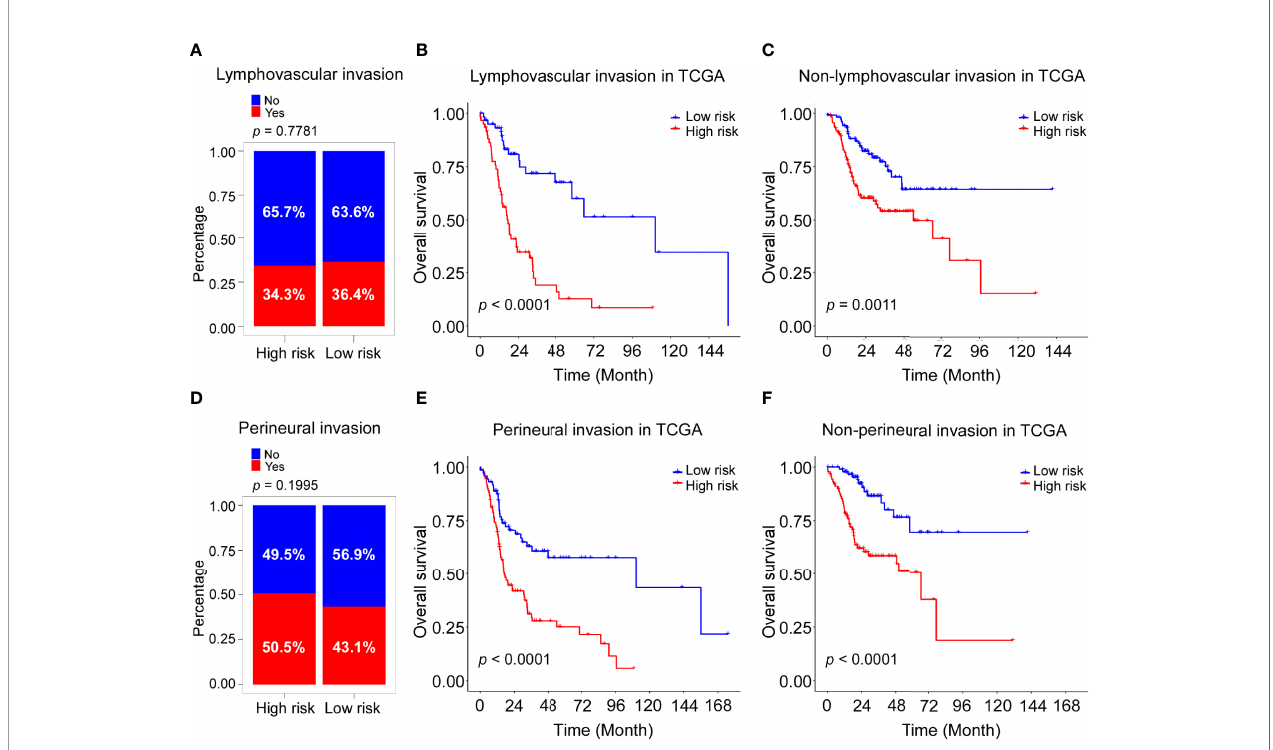
FIGURE 5 | Association of risk score with lymphovascular invasion and perineural invasion in TCGA cohort. (A) Rate of patients with lymphovascular invasion (Yes with No) in high and low risk groups in the TCGA-HNSC cohort. (B) Kaplan – Meier curves for the OS of high-risk and low-risk groups in the patients with lymphovascular invasion TCGA cohort. Log-rank test, P <0.0001. (C) Kaplan – Meier curves for the OS of high-risk and low-risk groups in the patients without lymphovascular invasion TCGA cohort. Log-rank test, P =0.0011. (D) Rate of patients with perineural invasion (Yes with No) in high and low risk groups in the TCGA-HNSC cohort. (E) Kaplan – Meier curves for the OS of high-risk and low-risk groups in the patients with perineural invasion TCGA cohort. Log-rank test, P <0.0001. (F) Kaplan – Meier curves for the OS of high-risk and low-risk groups in the patients without perineural invasion TCGA cohort. Log-rank test, P